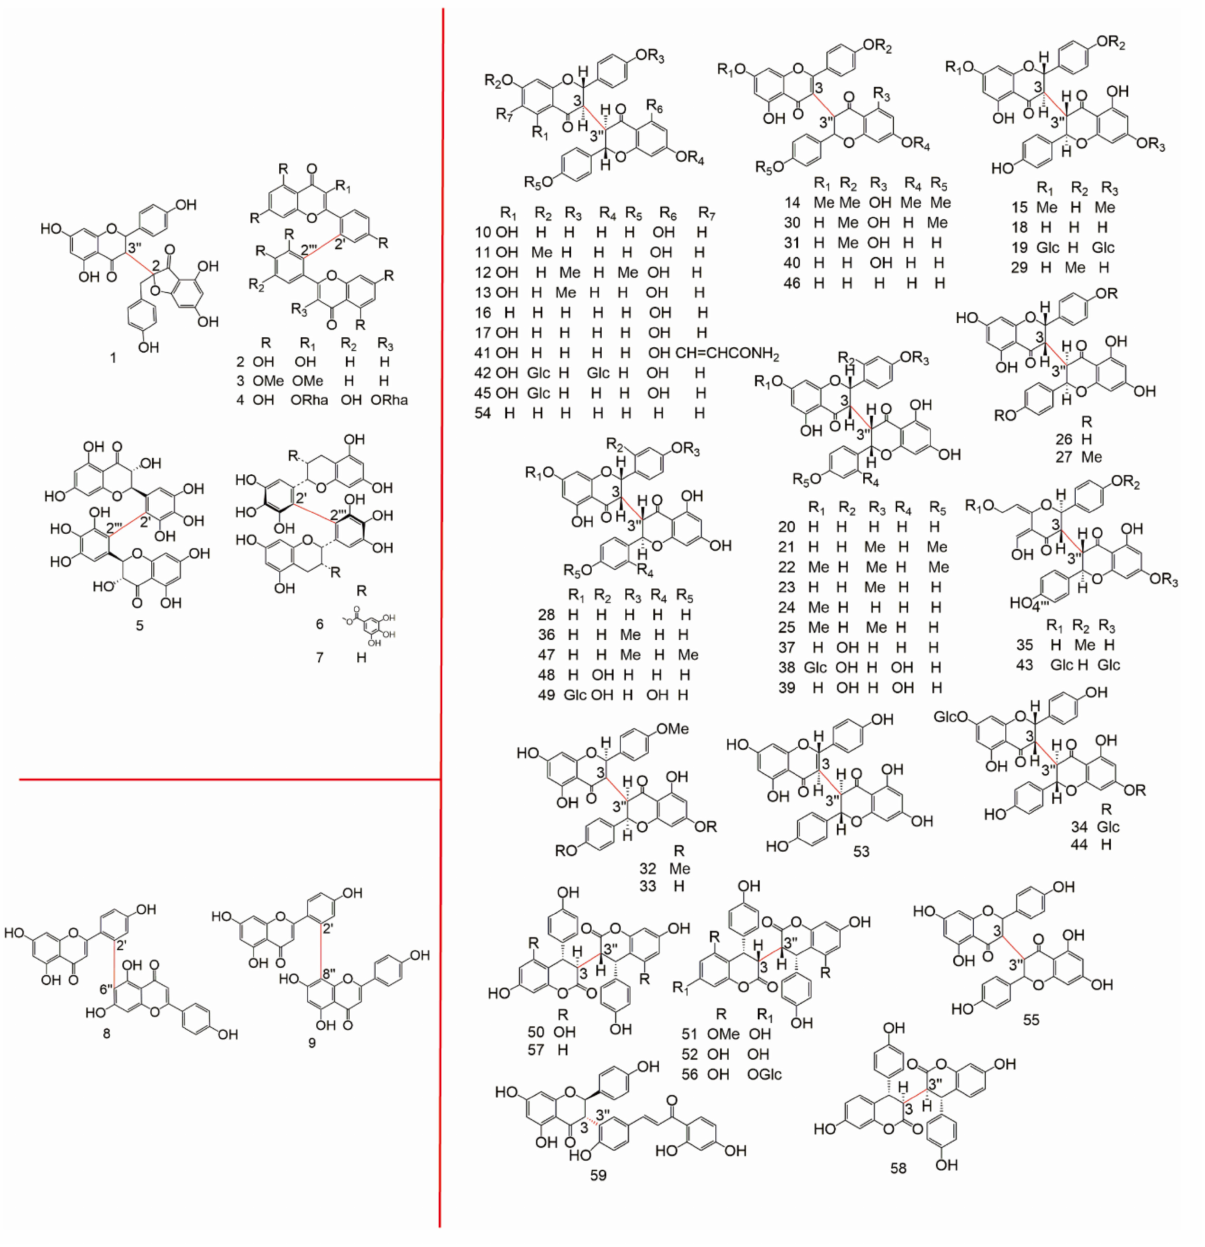
Figure 2. The structure of 2-3 (cid:48)(cid:48) , 2 (cid:48) -2 (cid:48)(cid:48)(cid:48) , 2 (cid:48) -6 (cid:48)(cid:48) , 2 (cid:48) -8 (cid:48)(cid:48) , and 3-3 (cid:48)(cid:48) type. The detailed data of 3-3 (cid:48)(cid:48)(cid:48) , 3 (cid:48) -3 (cid:48)(cid:48)(cid:48) , 3 (cid:48) -4 (cid:48)(cid:48)(cid:48) ,3 (cid:48) -5 (cid:48)(cid:48) , 3-6 (cid:48)(cid:48) , 3 (cid:48) -6 (cid:48)(cid:48) , 3-7 (cid:48)(cid:48) , 3 (cid:48) -7 (cid:48)(cid:48) type biflavonoids were showed in Table 2, the structure of them were drew in Figure